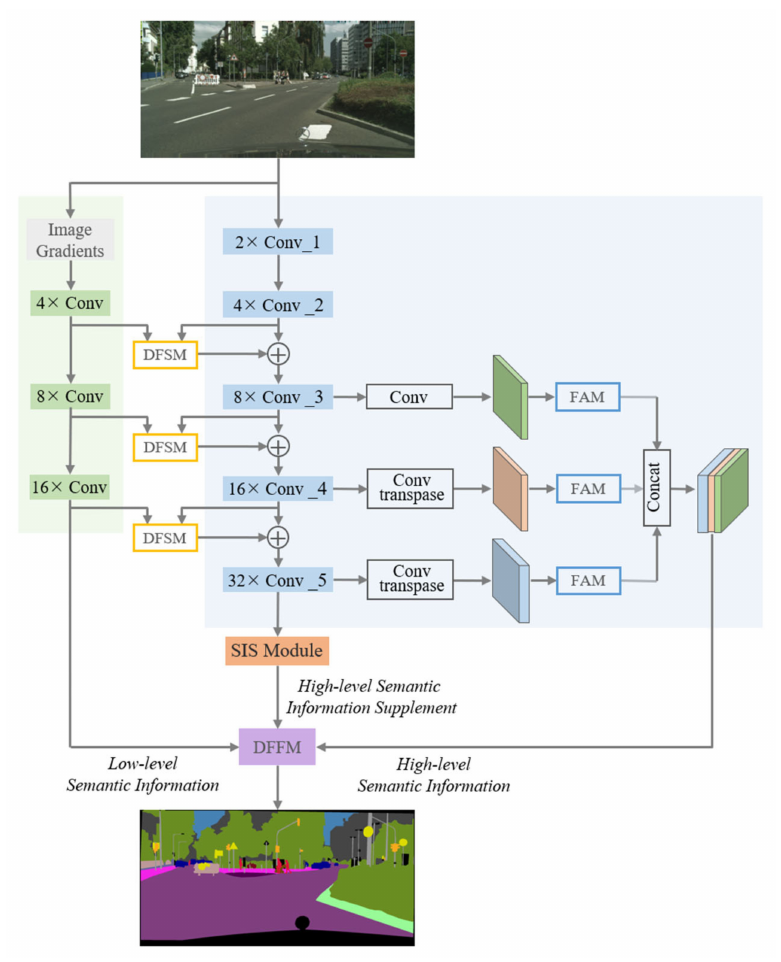
Figure 2. DGMNet network